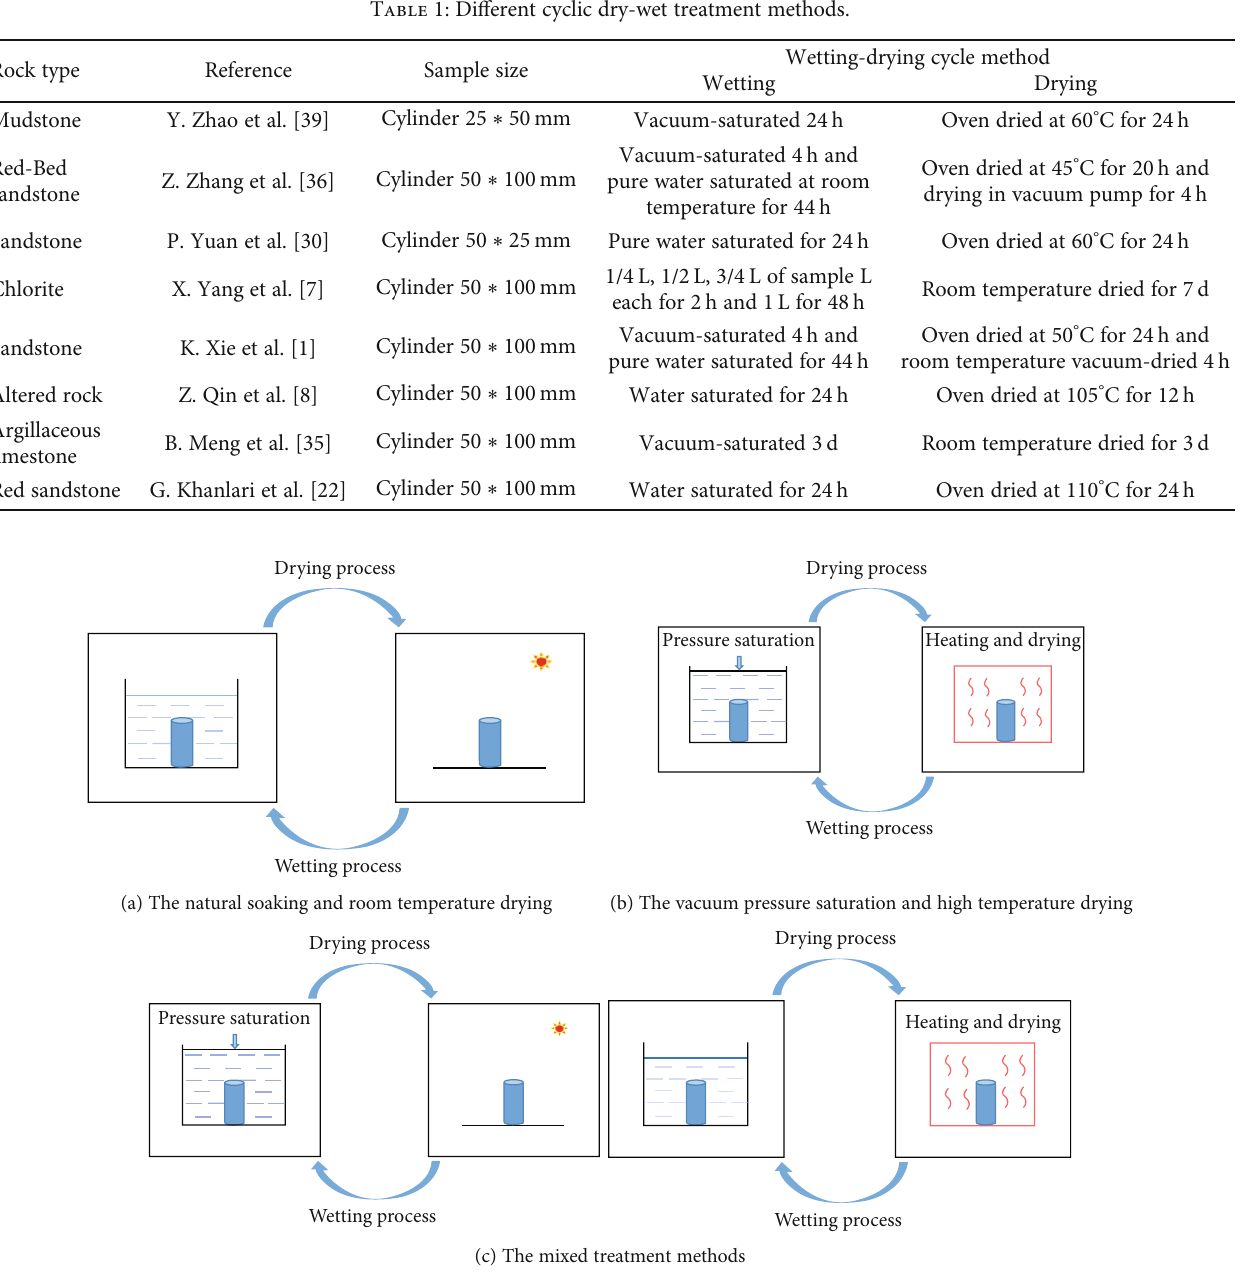
Figure 4: Three types of cyclic dry and wet treatment